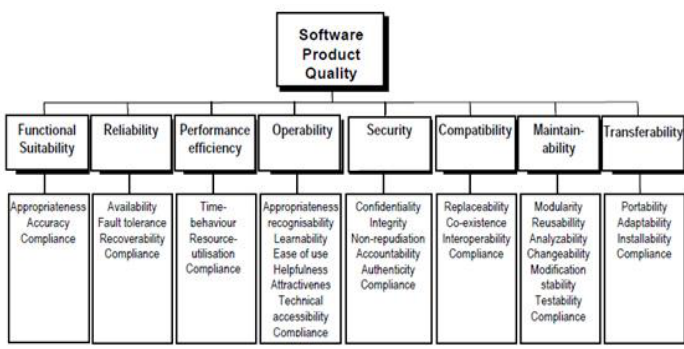
Figure 5 . Software Quality Model [ISO/IEC